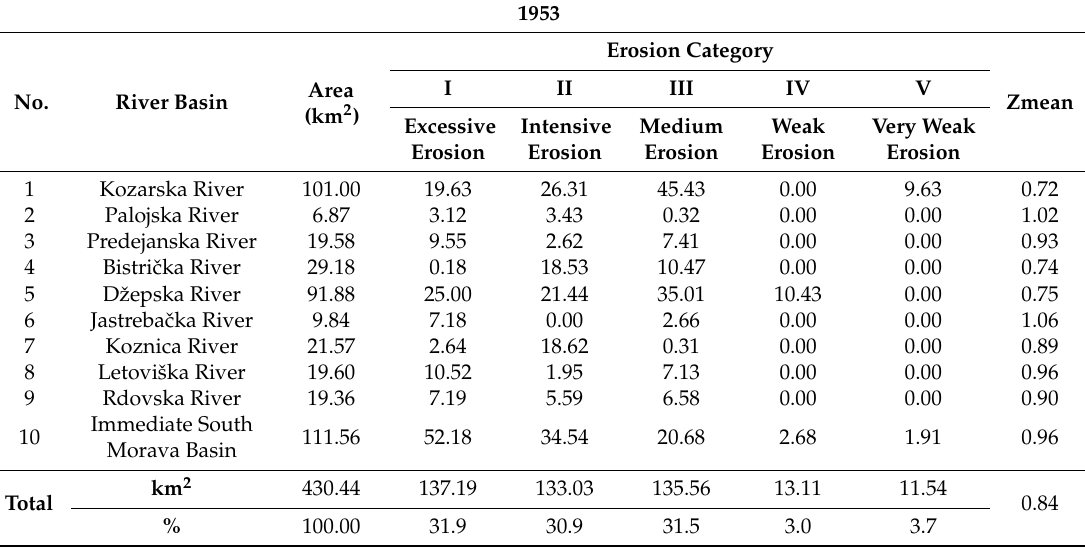
Table 6. Surface areas according to the intensity of soil erosion in 1953 [38] and